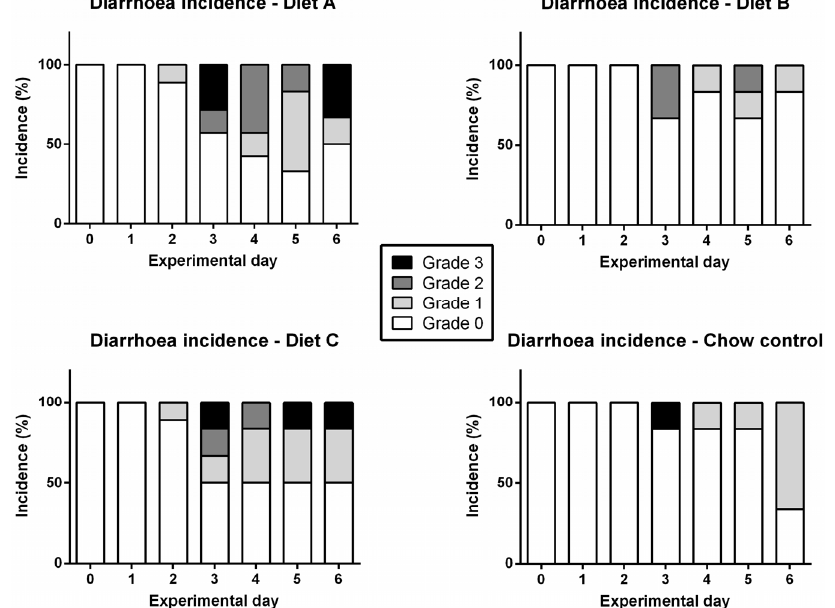
Figure 4. Incidence of diarrhea over six days in rats treated with chemotherapy